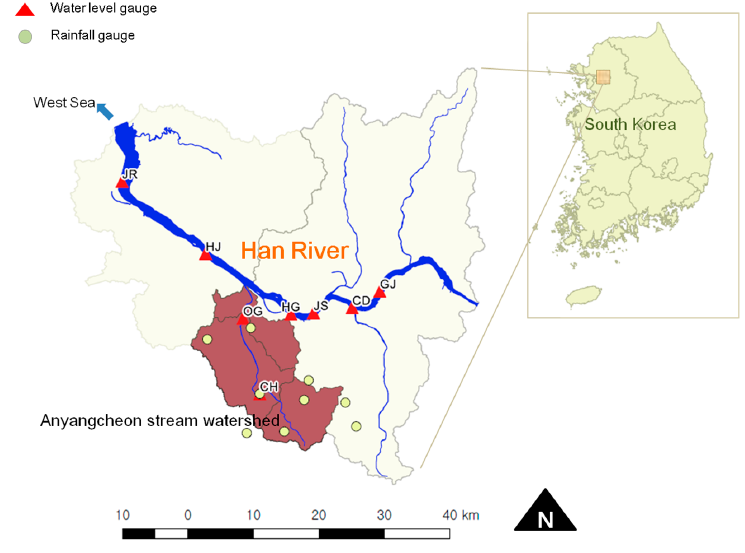
Figure 2. Study area showing Anyangcheon stream watershed and the Han River.